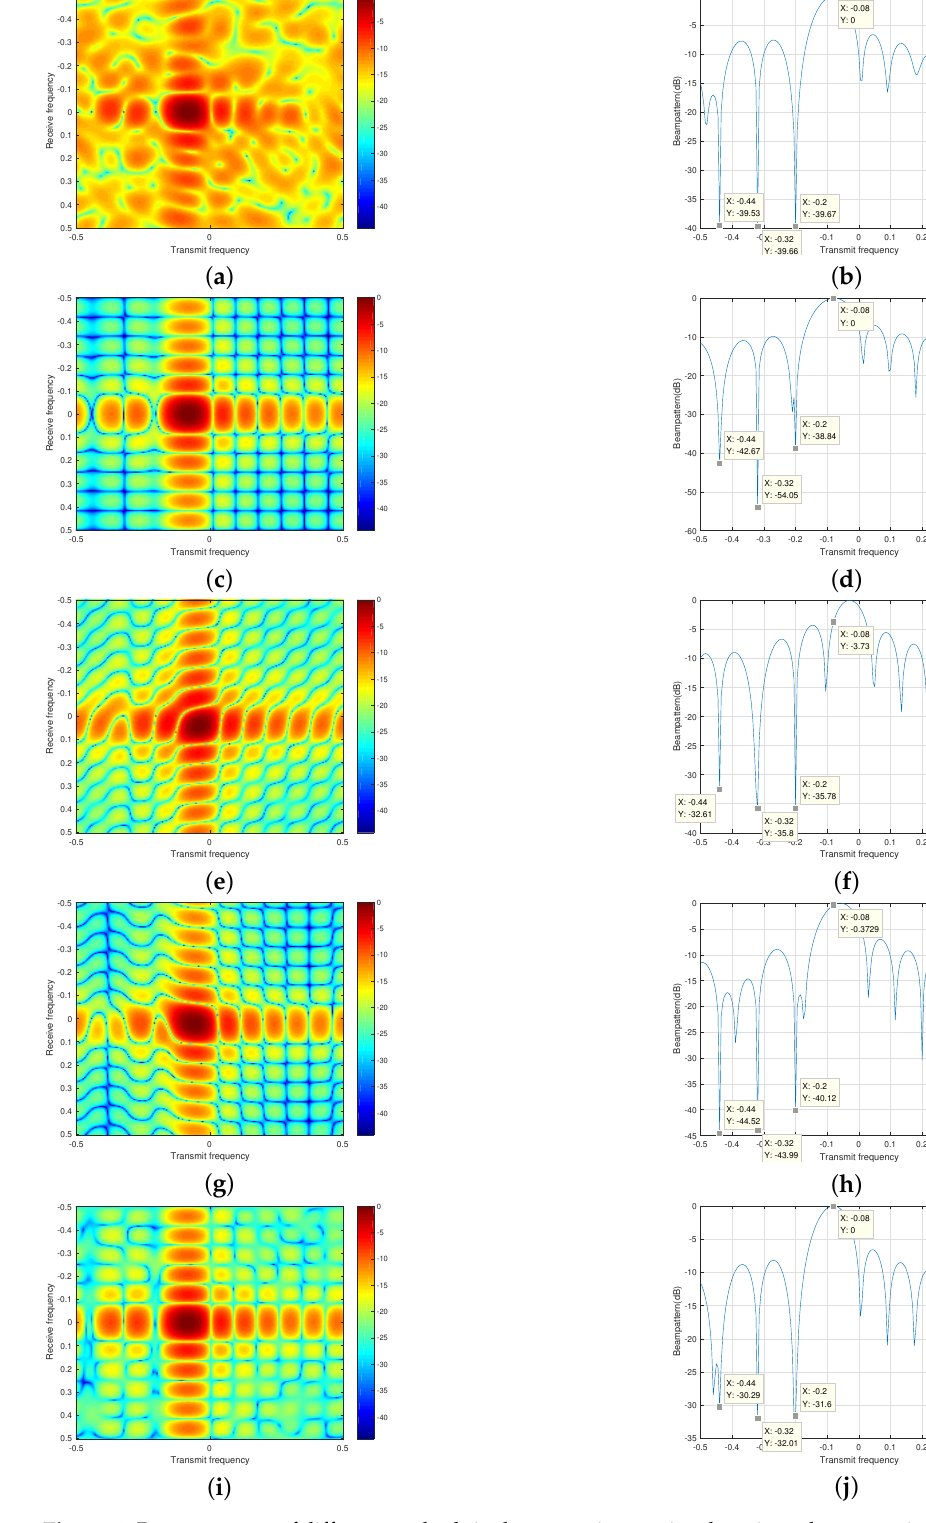
Figure 4. Beam-patterns of different methods in the transmit—receive domain and cross section at f r = 0 (SNR = 0 dB). ( a , b ) Optimal, ( c , d ) proposed method (with the steering vector (SV) estimation process), ( e , f ) LSMI-MVDR, ( g , h ) proposed method (without the SV estimation process), ( i , j ) Eigenspace